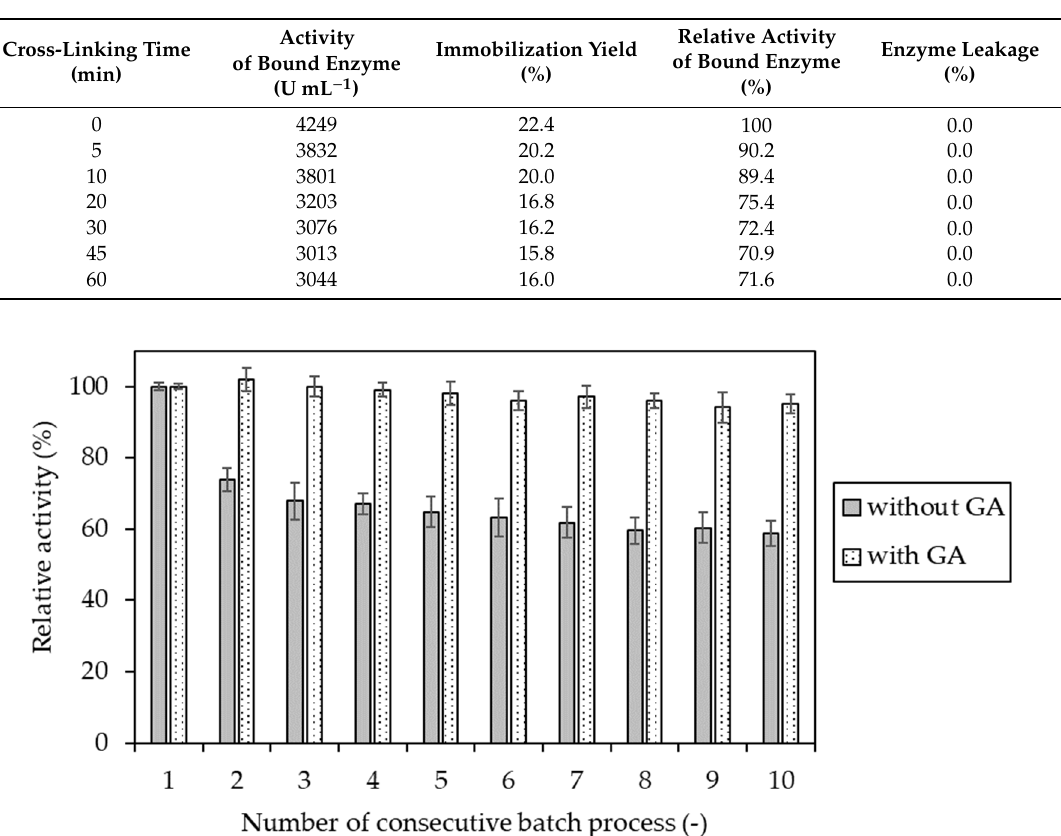
Table 8. E ff ect of the time of cross-linking with 0.5% glutaraldehyde (GA) on invertase immobilization in gelatin-based hydrogel.